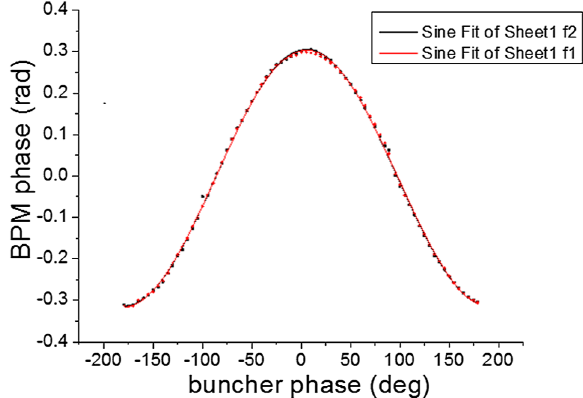
FIG. 15. Phase scan of the